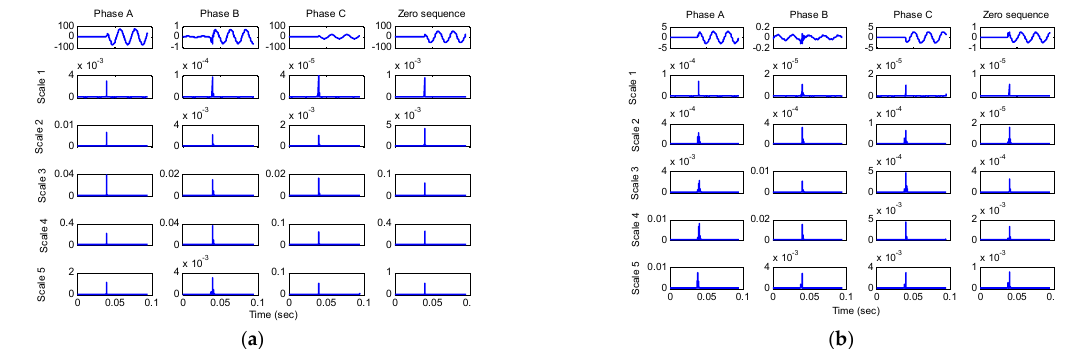
Figure 6. In the event of an internal winding problem, DWT of differential currents from scale 1 to scale 5: ( a ) analysis of high-voltage winding faults; ( b ) analysis of low-voltage winding faults.